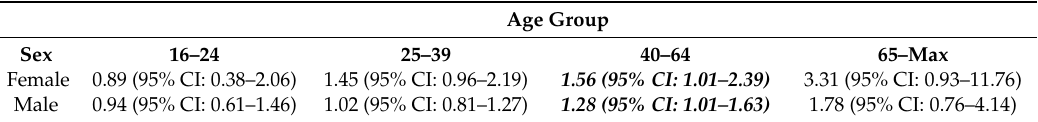
Table 2. Sex and Age group stratified odds ratios * (95% CI) for the outcome ambulant discharge for the comparison NA vs. Swiss ( n = 116,859). (significant associations in italic and bold).